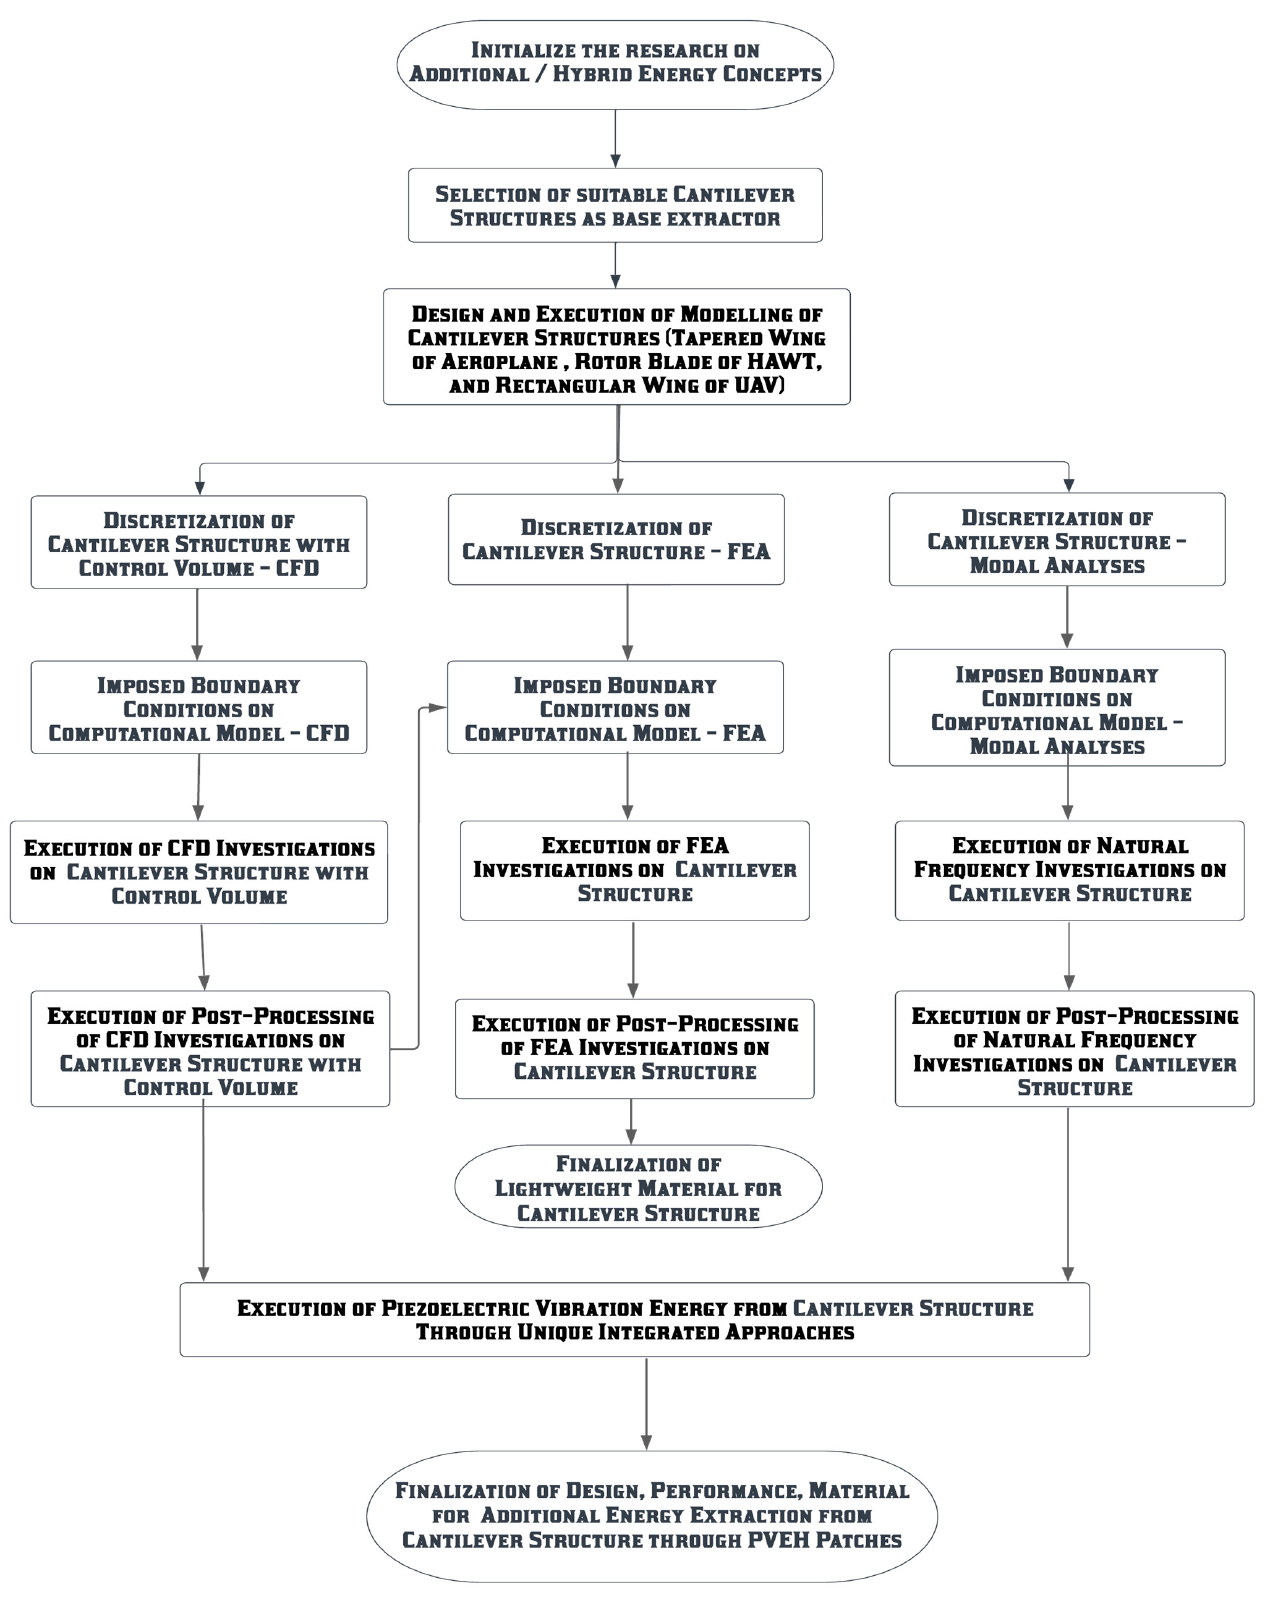
Figure 1. Procedures involved in this proposed approach for the additional/hybrid energy extraction concepts.